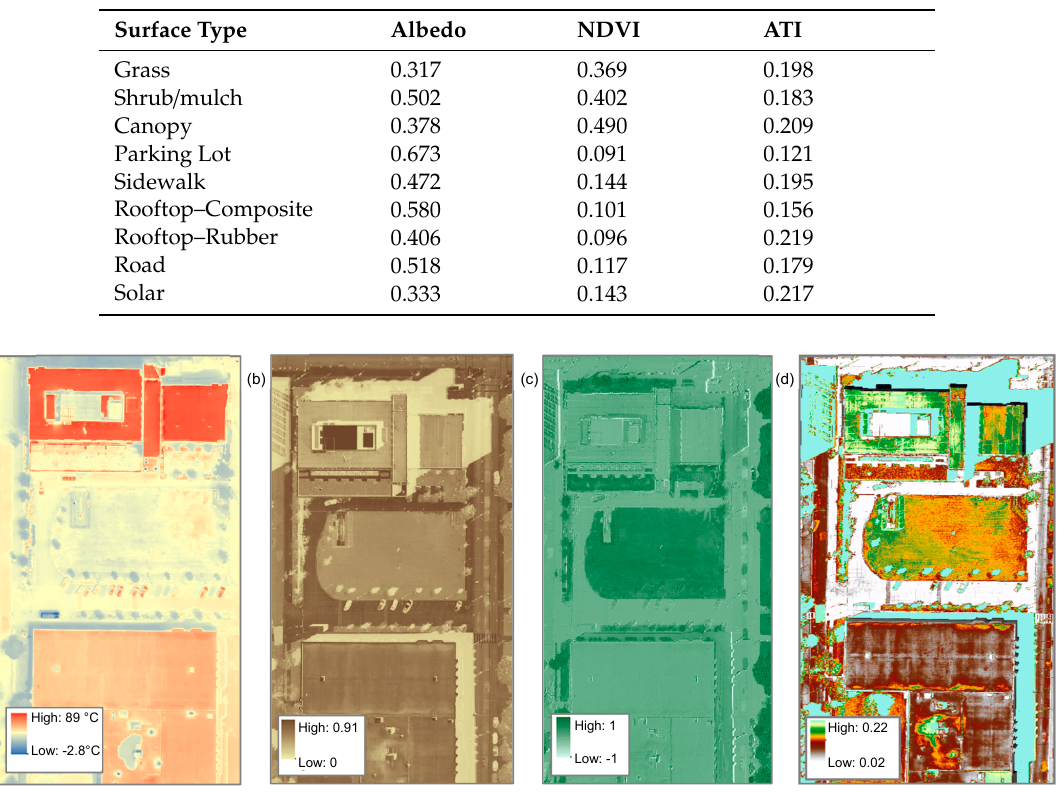
Figure 7. Spatial distribution of tempearture ( a ), albedo ( b ), NDVI ( c ) and ATI ( d ) for a flight recorded on 11 August 2018.